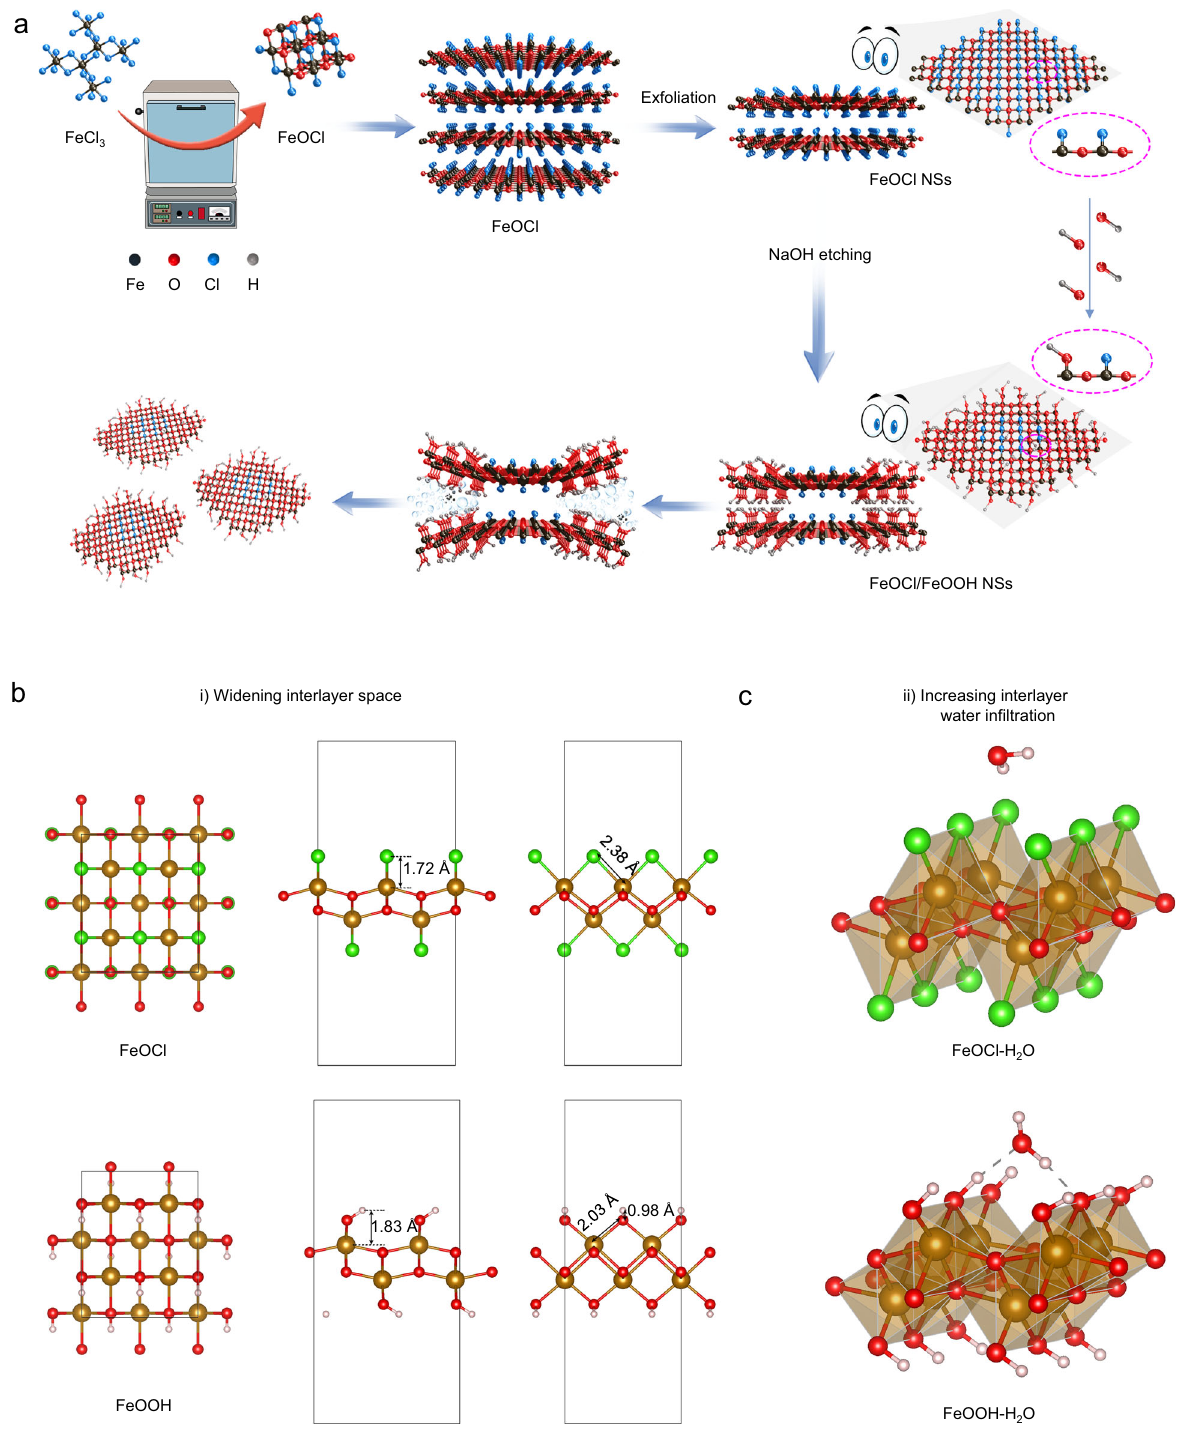
Fig. 1 Schematic illustration of preparation of FeOCl/FeOOH nanosheets (NSs) for ef fi cient catalytic cancer therapy. a FeOCl/FeOOH NSs with Z- schemed heterojunction were fabricated by hydrothermal process, liquid exfoliation, and NaOH etching. A smart wet-chemical method based on alkali replacement reaction was developed to intelligently integrate interplanar heterojunction synthesis and two-dimensional ultrathin heterojunction exfoliation in one step. b The fully optimized structures of the FeOCl and FeOOH NSs with caculated bond length of Fe-Cl in FeOCl and bond lengths of Fe-O and O-H in FeOOH. c The most stable adsorption con fi gurations of H 2 O molecule on FeOCl and FeOOH